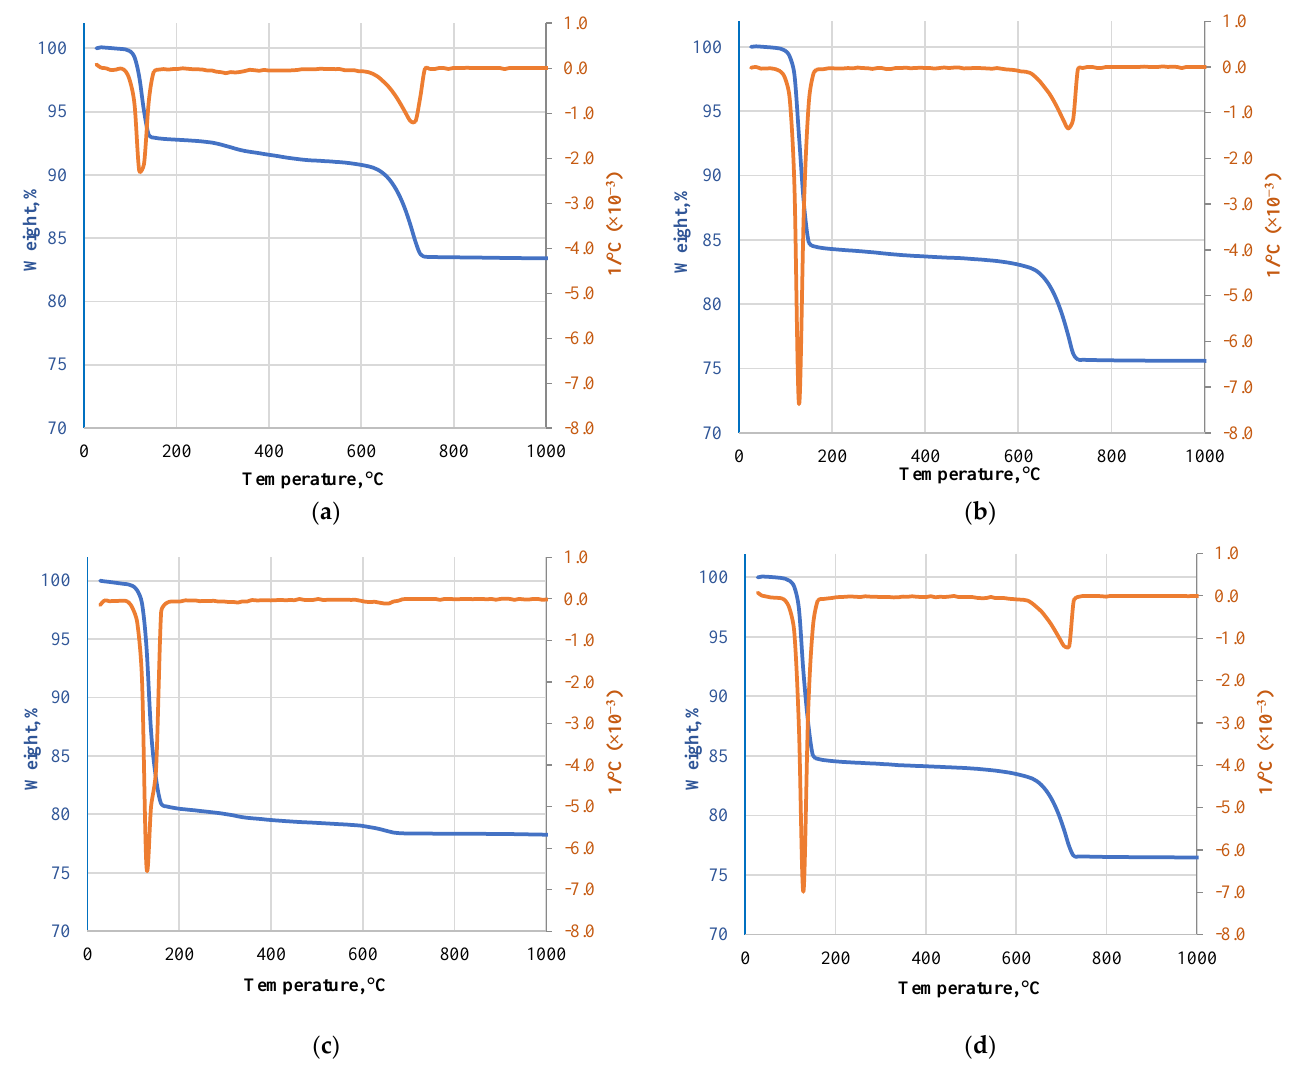
Figure 4. DTA/TG results of different types of gypsum CDW: ( a ) MG; ( b ) Type F; ( c ) Type H; ( d ) Type A.